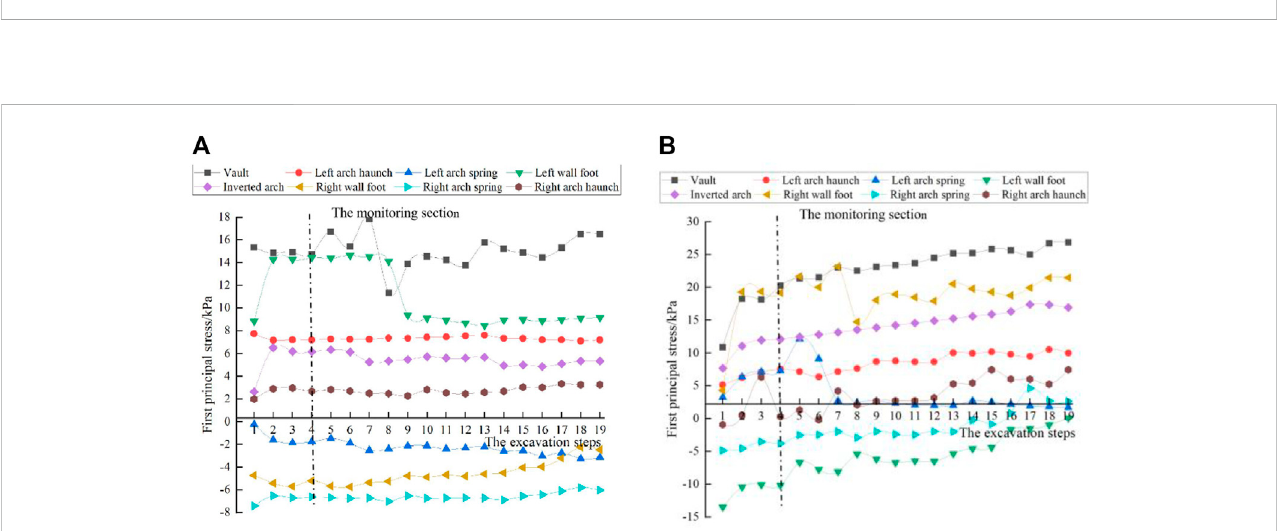
FIGURE 8 First principal stress of lining structure: (A) Stress at the12-cm section outside of the structure and (B) Stress at the 12-cm section inside of the structure.